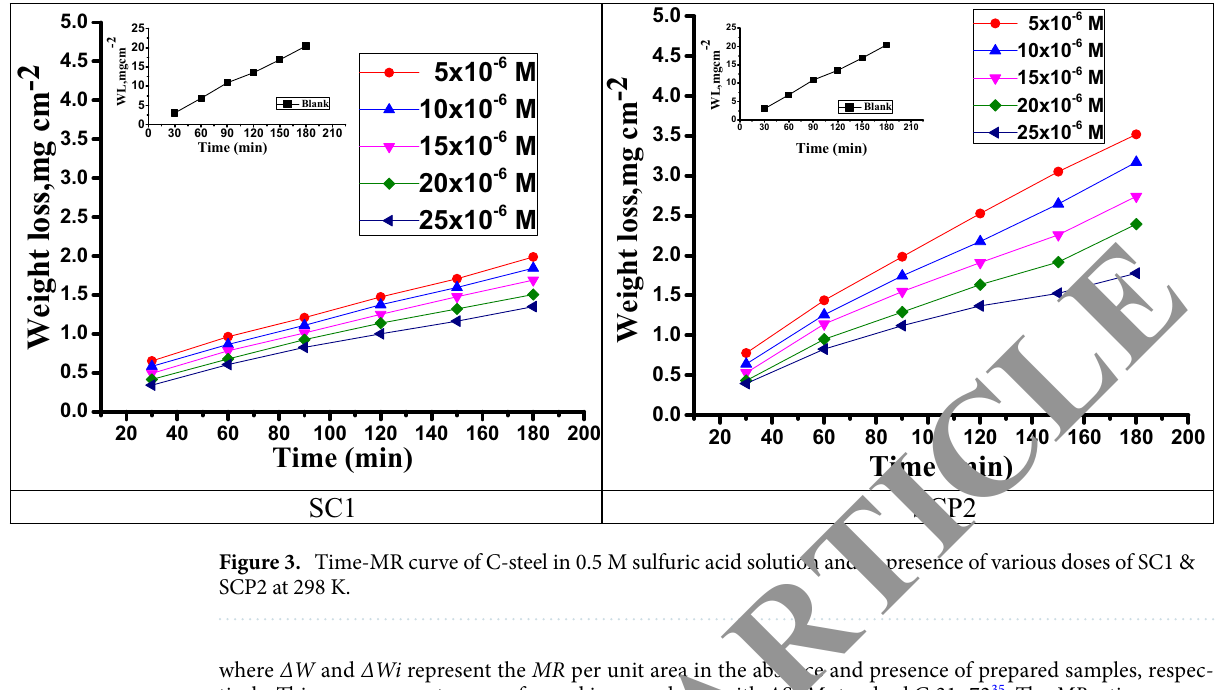
Figure 3. Time-MR curve of C-steel in 0.5 M sulfuric acid solution and in presence of various doses of SC1 & SCP2 at 298